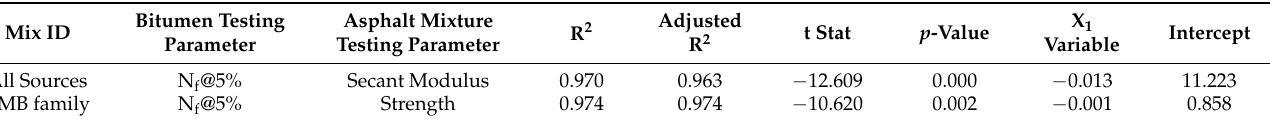
Table 10. Best correlated parameters and testing conditions of bitumen LAS parameter with SCB@25 ◦ C). Mix